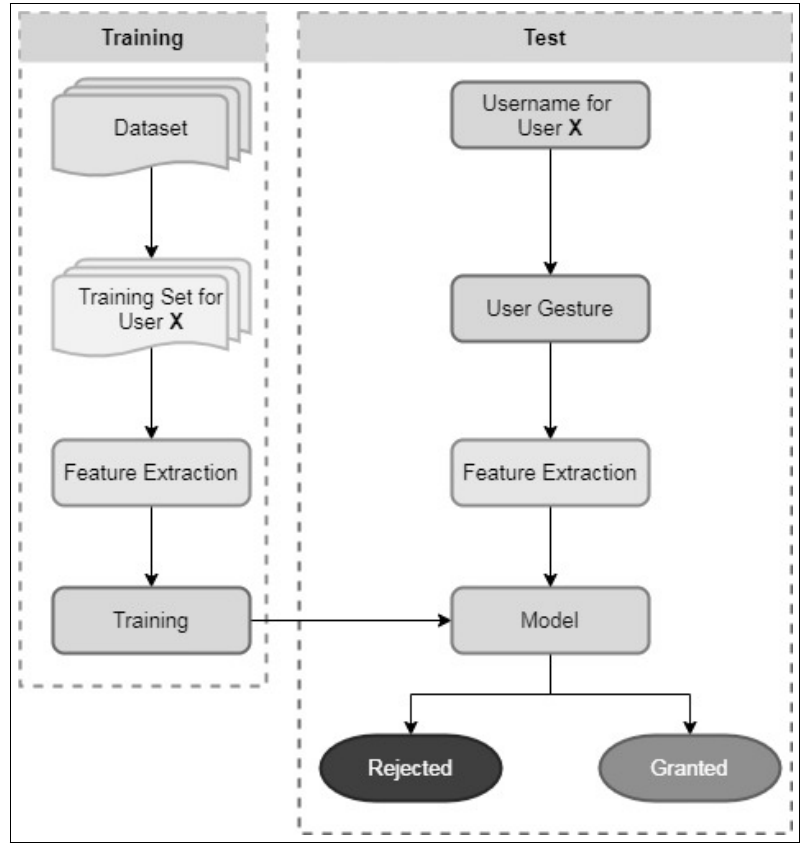
Figure 1. EMG verification system schematic